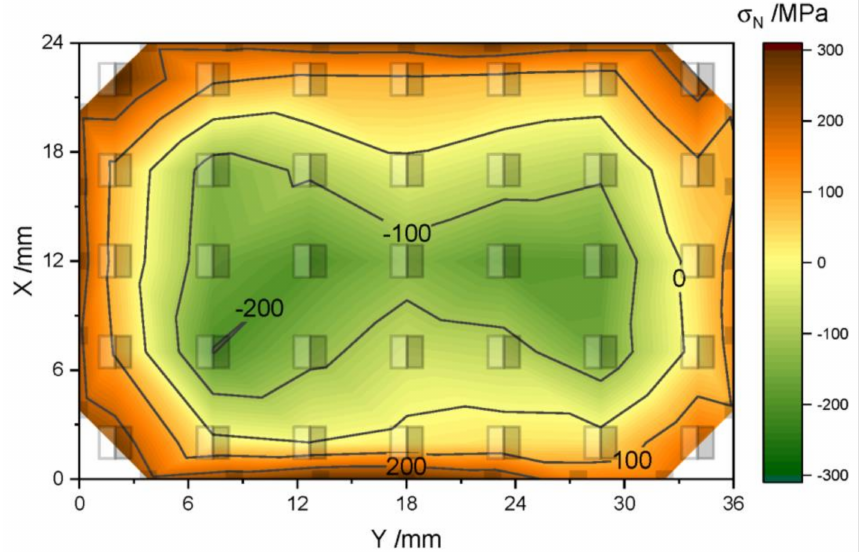
Figure 4. Example of a stress distribution along the build direction ( σ N ) in LPBF of 316L prisms measured by ND (bulk) and lab X-ray (surface). Reproduced from